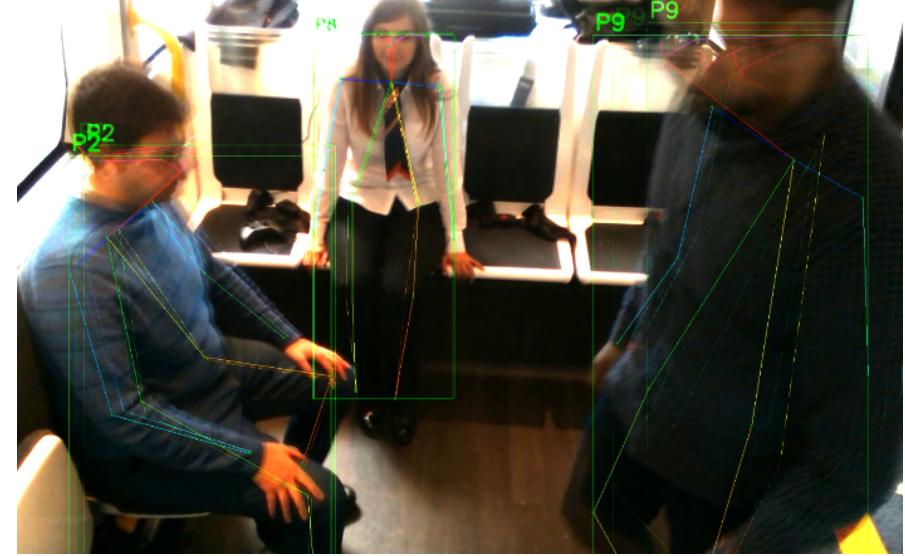
Figure 4. Skeleton matching across two subsequent frames (blended). Notice that the passenger ID, highlighted in green at the left of each bounding box, is the same across the frames.